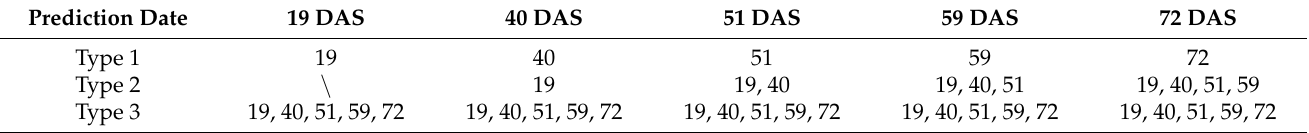
Table 2. Temporal combination of datasets of explanatory variables to build models for estimates at each prediction date (represented by days after sowing, DAS). Temporal combinations were grouped into three types (Type 1, 2, and 3; see text for details). The number set in each cell represents dates of dataset collection and is a temporal combination of datasets of explanatory